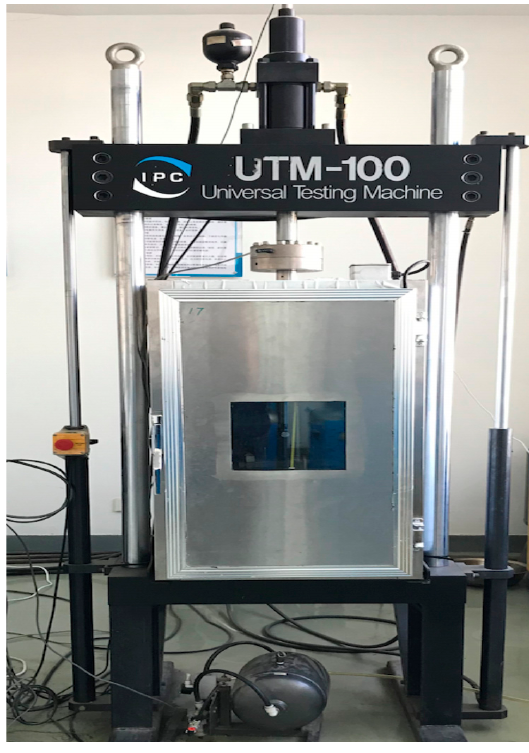
Figure 3. The UTM-100 machine setup.